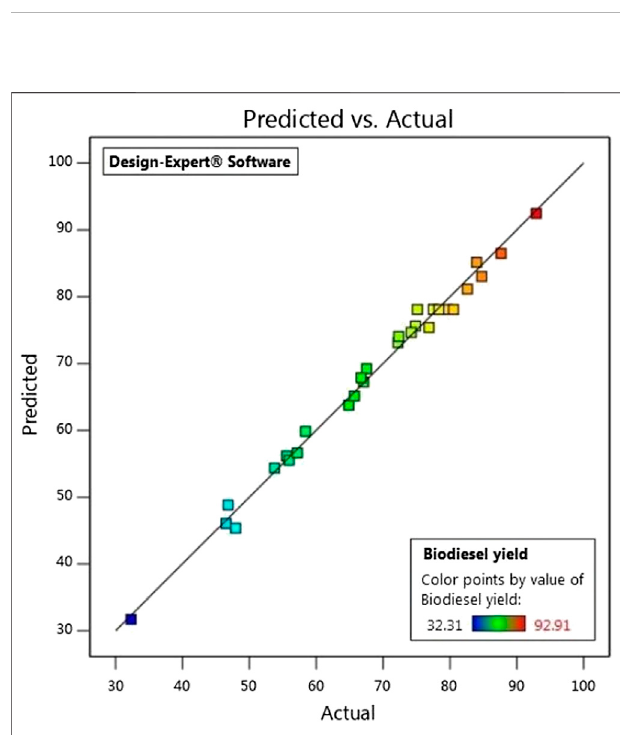
FIGURE 3| GC chromatogram of the esters formed from acid catalyzed conversion of castor oil.